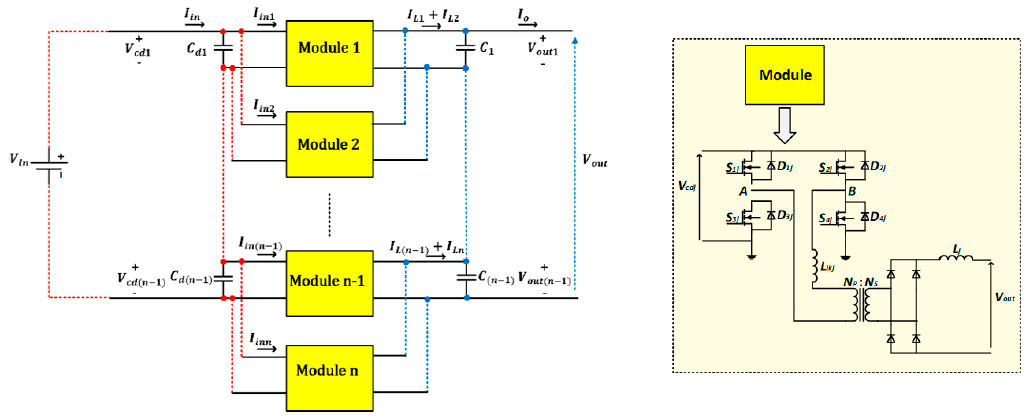
Figure 7. Generalized multimodule DC-DC converter circuit diagram.